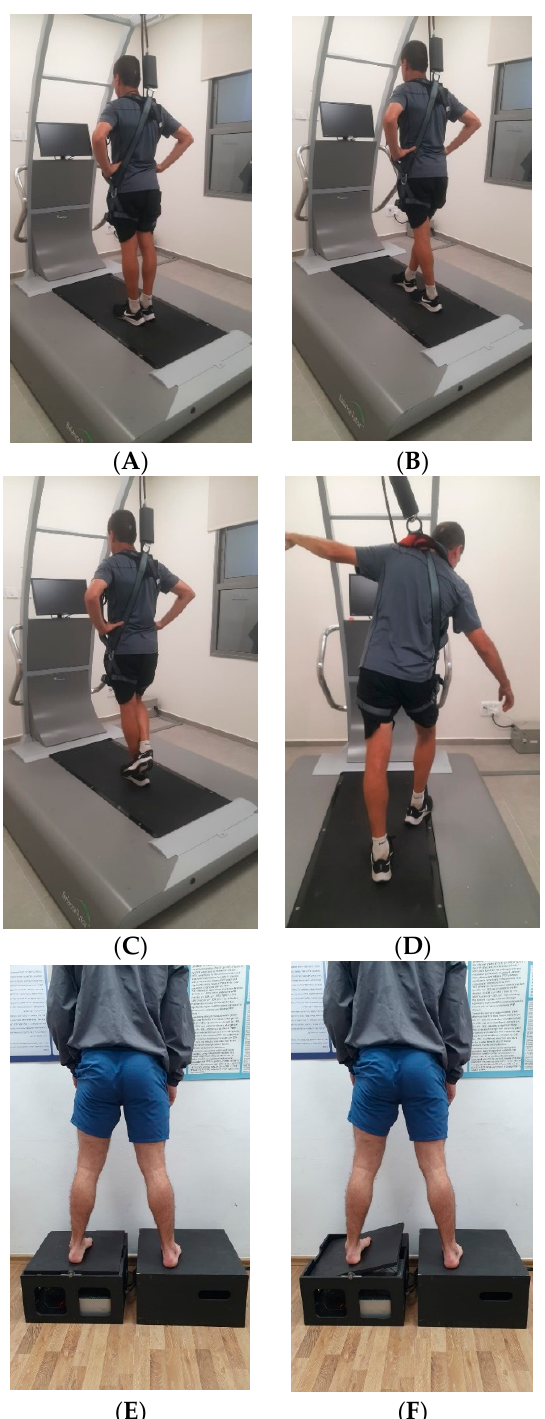
Figure 1. Different starting position on BalanceTutor device ( A – D ); and, assessing the extent of the inversion angle on the AMEDA device ( E , F ): ( A ) eyes open position and eyes closed position; ( B ) tandem-dominant leg forward position and tandem non-dominant leg forward position; ( C ) single leg same side position and single leg opposite side position; ( D ) “Loss of postural control”; ( E ) horizontal position on the AMEDA; and ( F ) position 5 on the AMEDA.